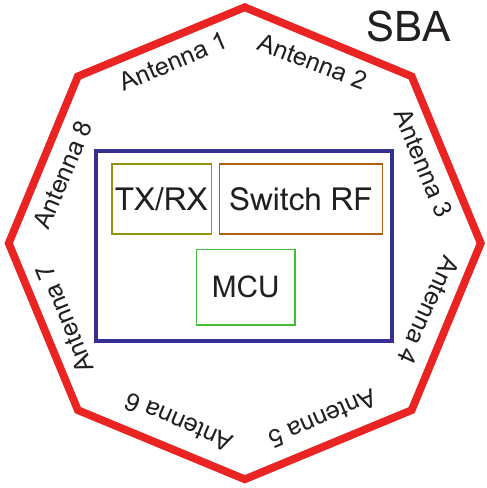
Figure 2. SBA of the proposed anchor